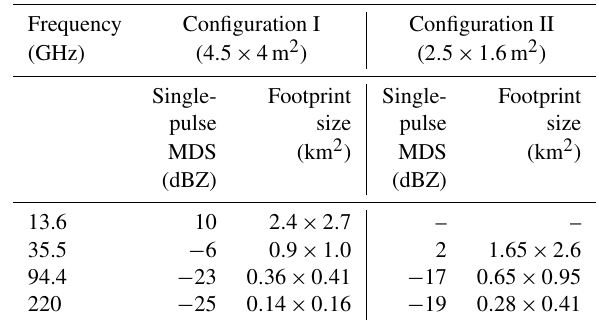
Table 1. Summary of specifications for two radar configurations currently under study: one with a very large antenna and one with a smaller antenna. A flying altitude of 400km and a range resolution of 500m are assumed. MDS is minimum detection